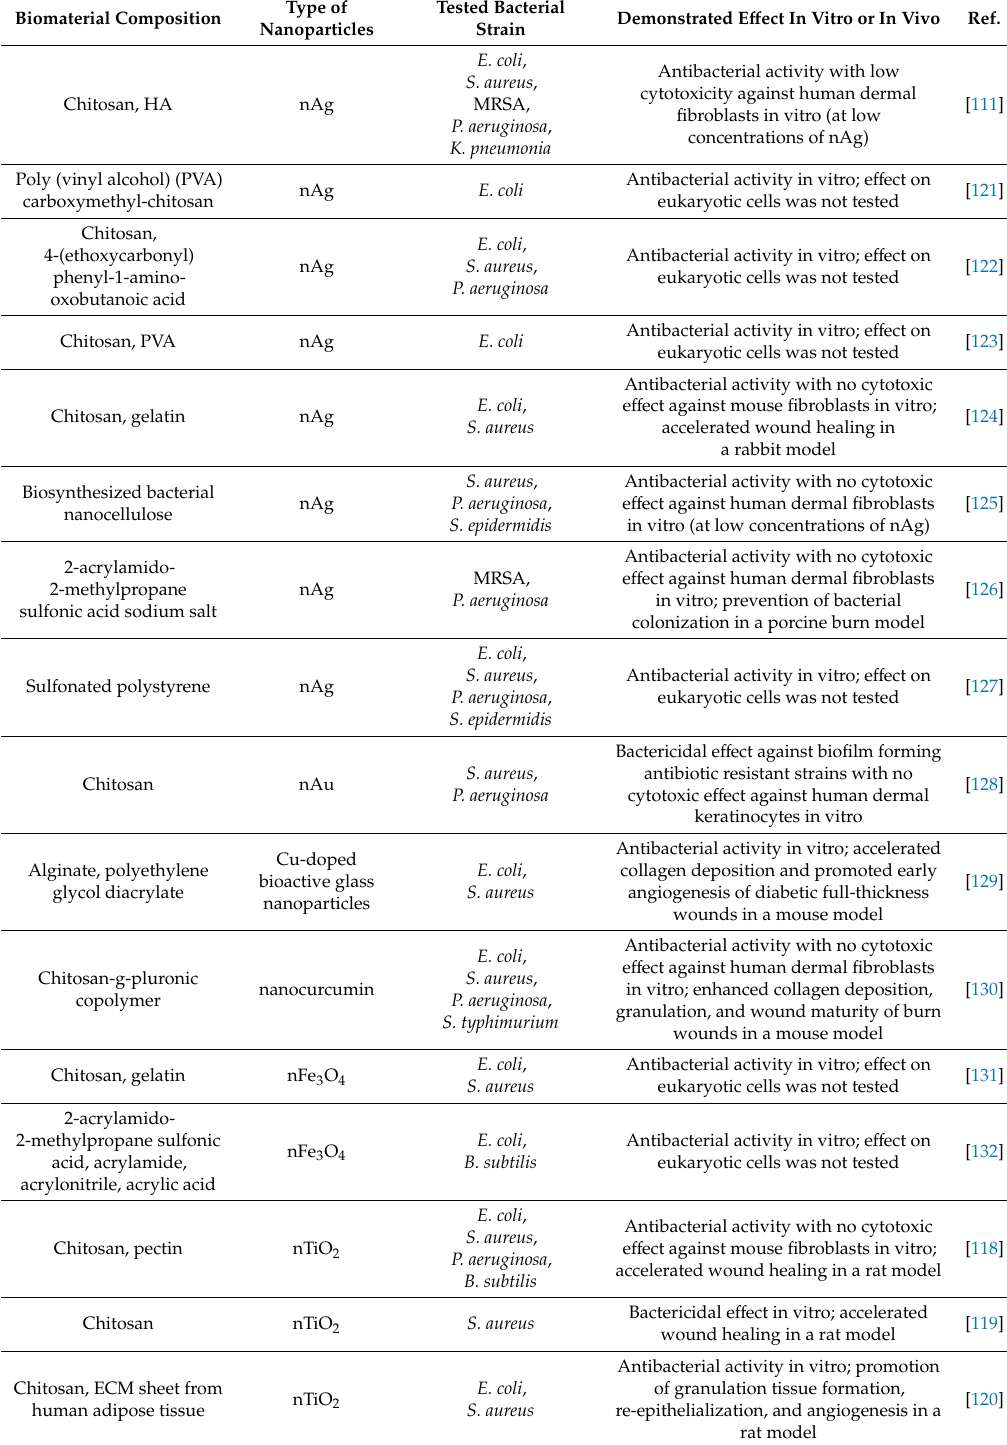
Table 2. Nanocomposite biomaterials with antibacterial properties for potential use as artificial skin grafts and wound